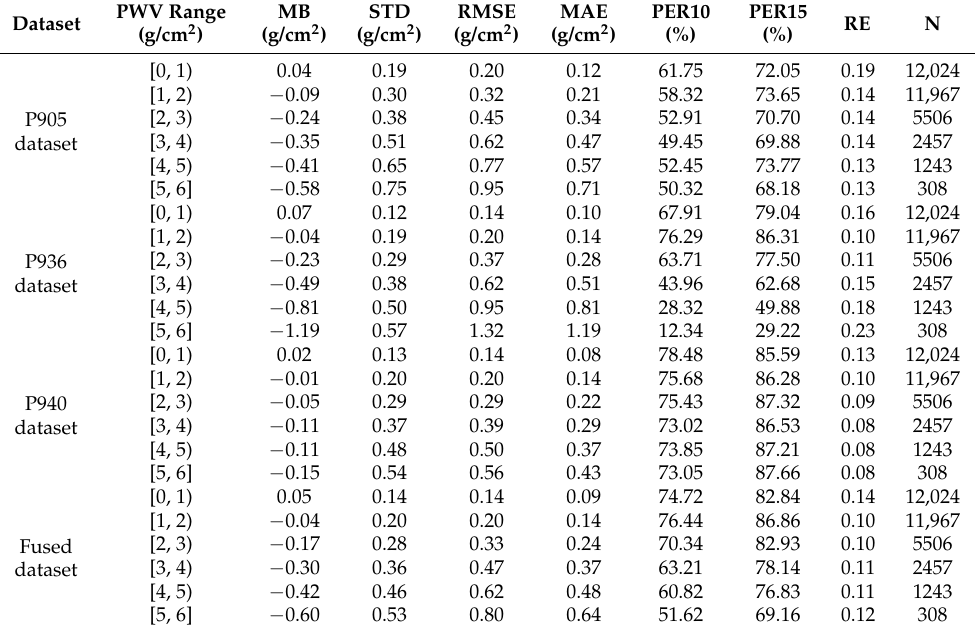
Table 3. Statistical parameters of the four MERSI-2 PWV datasets in different PWV